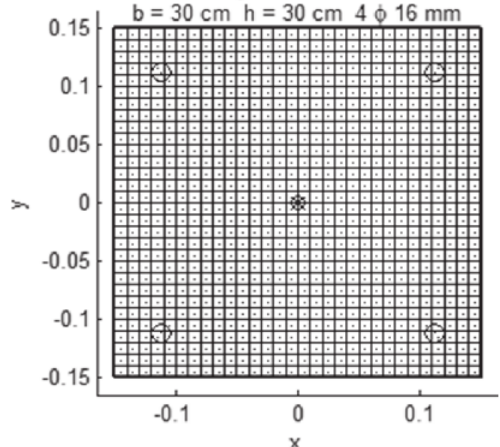
Figura 14a Seção transversal com 4 ϕ 16 mm